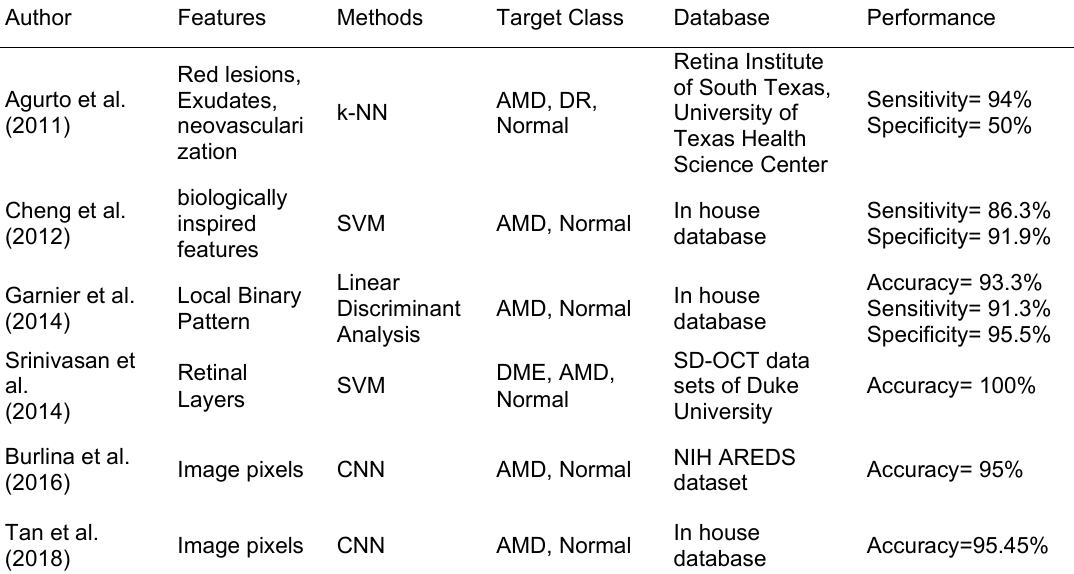
Table 4. State-of-the-Art of AMD